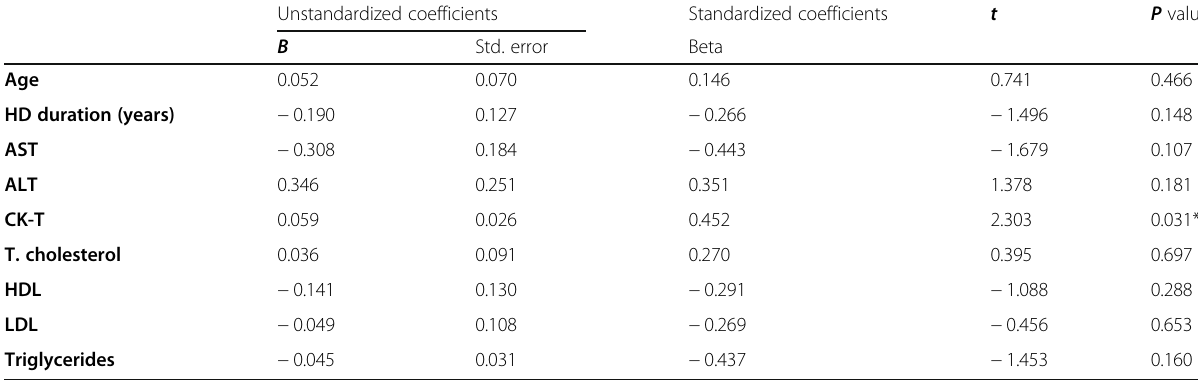
Table 7 Linear regression analysis displaying independent predictors of hs-CRP after 6 months Unstandardized